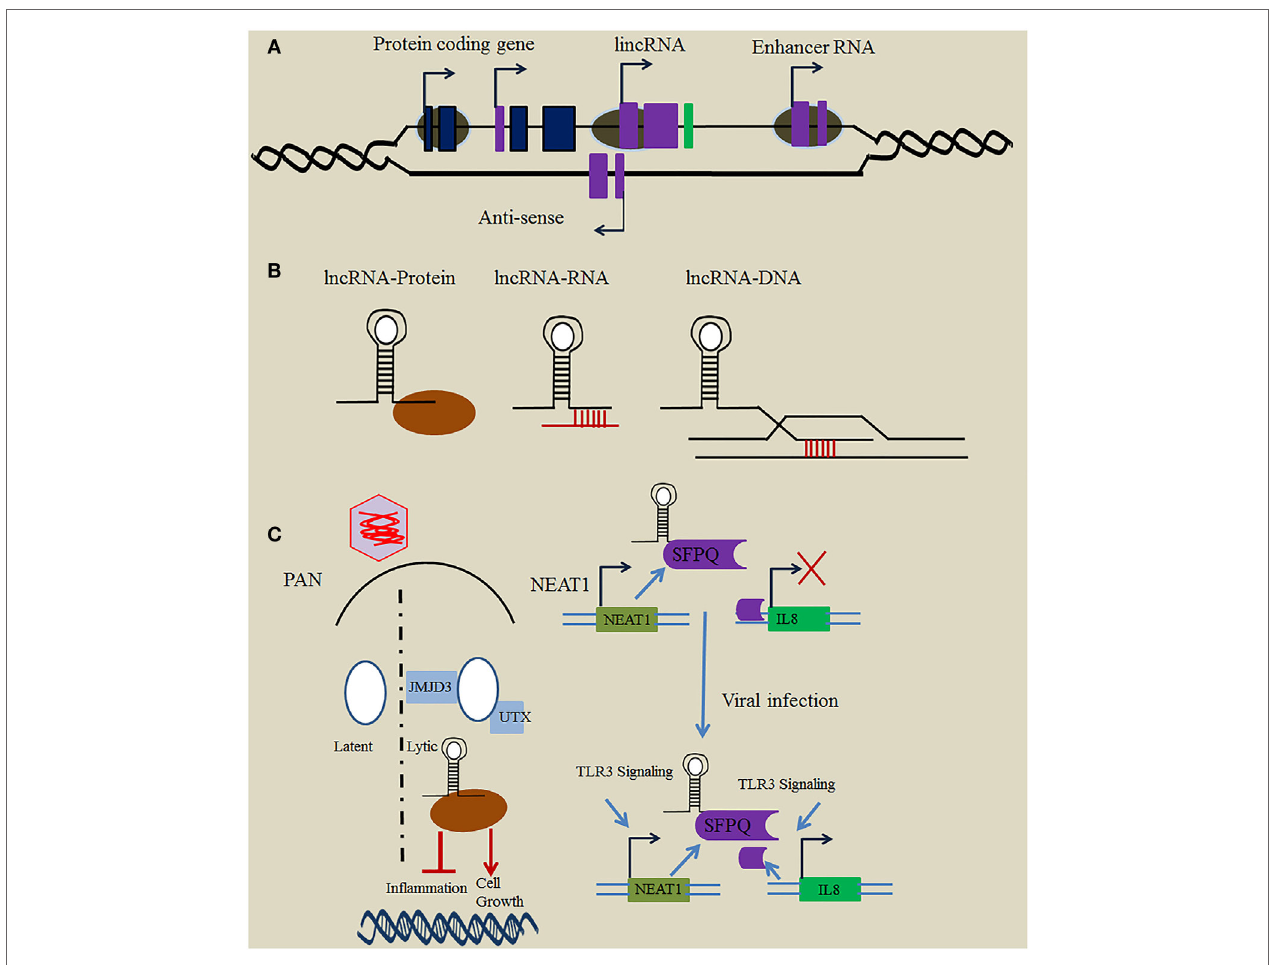
FigURe 1 | Mechanism employed by long non-coding RNA (lncRNA) in immune regulation. (A) Loci of immune-related lncRNAs relative to protein-coding genes. In general, immune-related lncRNAs are transcribed by RNAP II and classified relative to the position of the neighboring protein-coding gene into different types, including intronic lncRNA, long intergenic ncRNA (lincRNA), enhancer RNA (eRNA), and antisense lncRNA. (B) Mechanisms employed by lncRNAs. lncRNAs use a variety of basic modules to perform their regulatory functions in the cytosol and nucleus through lncRNA–protein, lncRNA–RNA, and lncRNA–DNA interactions. (C) Function of herpesviruses’ lncRNAs in immune regulation. The Kaposi’s sarcoma-associated herpesvirus (KSHV)-encoded lncRNA polyadenylated nuclear (PAN) binds the histone-modifying complex (demethylases JMJD3 and UTX) which plays an important role in the switch from latent to lytic infection. PAN also subverts the host immune response and modulates viral gene expression through binding with PRC2 to promote cell growth and survival, and to repress the inflammatory response. Nuclear paraspeckle assembly transcript 1 (NEAT1) binds several proteins such as SFPQ, and plays a critical role in regulation of the innate immune response mechanism through the transcriptional regulation of numerous antiviral genes upon herpesvirus